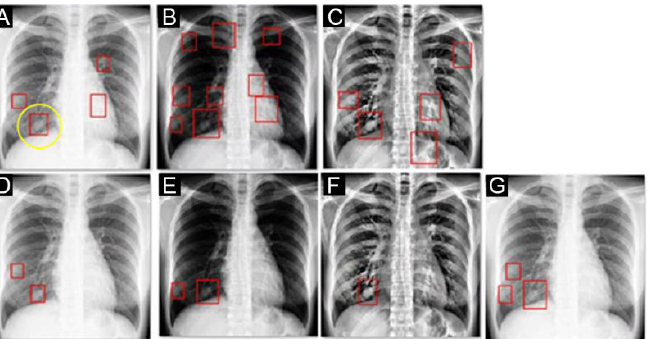
Figure 8. Example of the same CXR with different preprocessing and nodules detected with different models (red box). The true lesion is presented with a yellow circle in ( A ). ( A , D ) The original CXRs were preprocessed with default normalization, and lesions were detected with the YOLOv4- based default model with score thresholds of 0.0001 and 0.01, respectively. ( B , E ) The CXRs were preprocessed with gamma correction and lesions were detected with the YOLOv4-based gamma correction models with score thresholds of 0.0001 and 0.01, respectively. ( C , F ) The CXRs were preprocessed with CLAHE, and lesions were detected with the YOLOv4-based CLAHE models with score thresholds of 0.0001 and 0.01, respectively. ( G ) The CXRs were preprocessed with default normalization, and the lesions were detected with ensemble model, which was derived from the default model at the 0.01 threshold, the gamma correction model at the 0.01 threshold, and the CLAHE model at the 0.01 threshold.